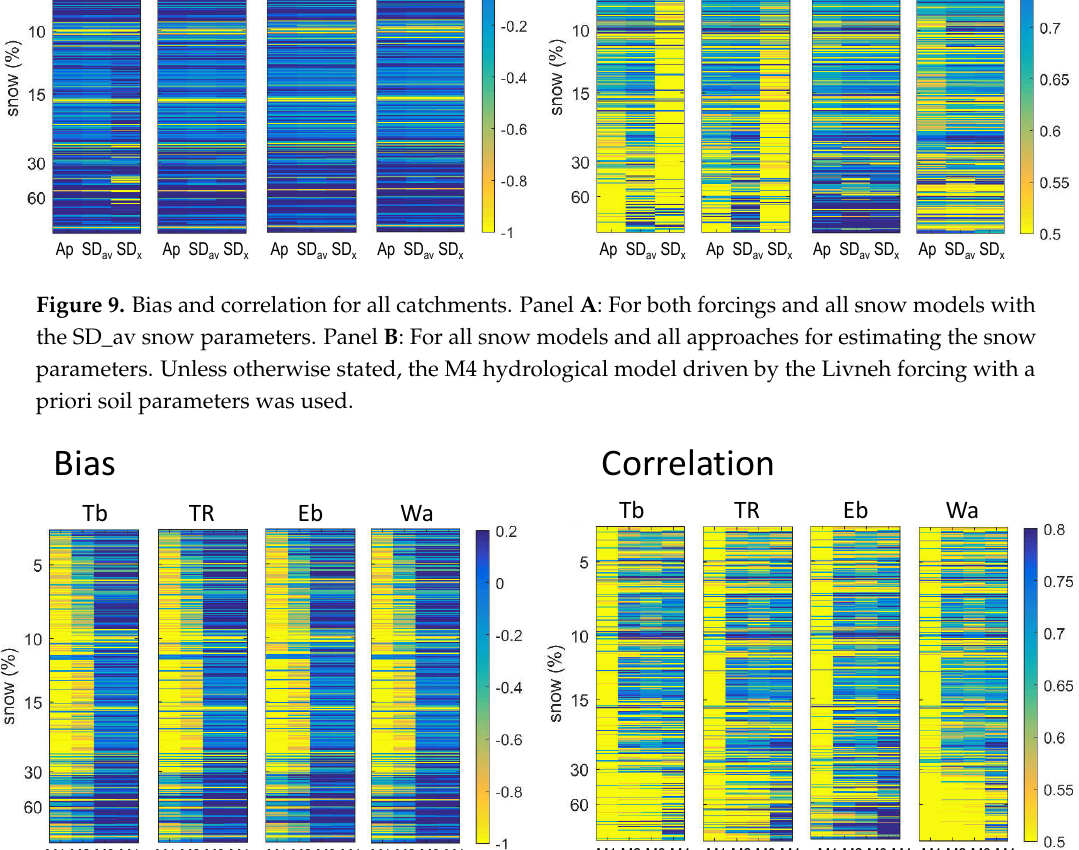
Figure 10. Bias and correlation for the snow models with the SD_av snow parameters and a priori soil parameters. All hydrological models are driven by the Livneh